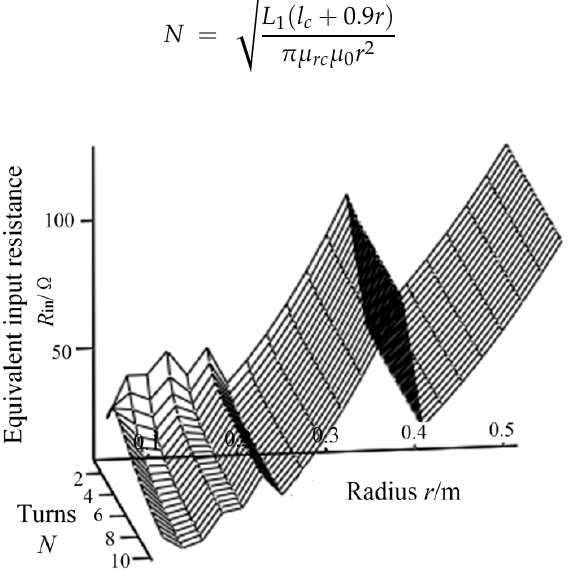
Figure 6. Relationship between the input resistance, N and r.